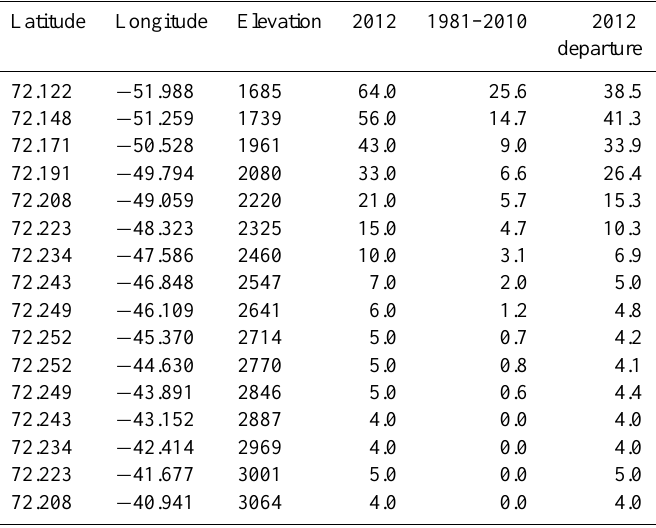
Table 2. Melt duration (in days) for JJA 2012 and the 1981–2010 average (days) for a transect in West Greenland at approximately 72 ◦ N using the algorithm in Mote and Anderson (1995).